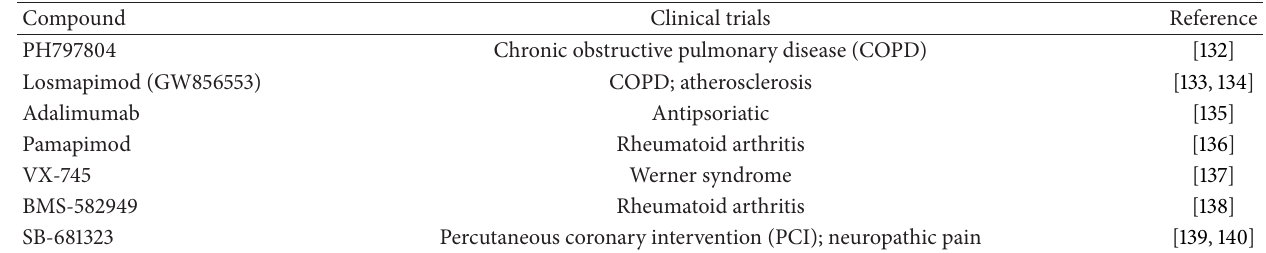
Table 4: p38 inhibitors under human clinical